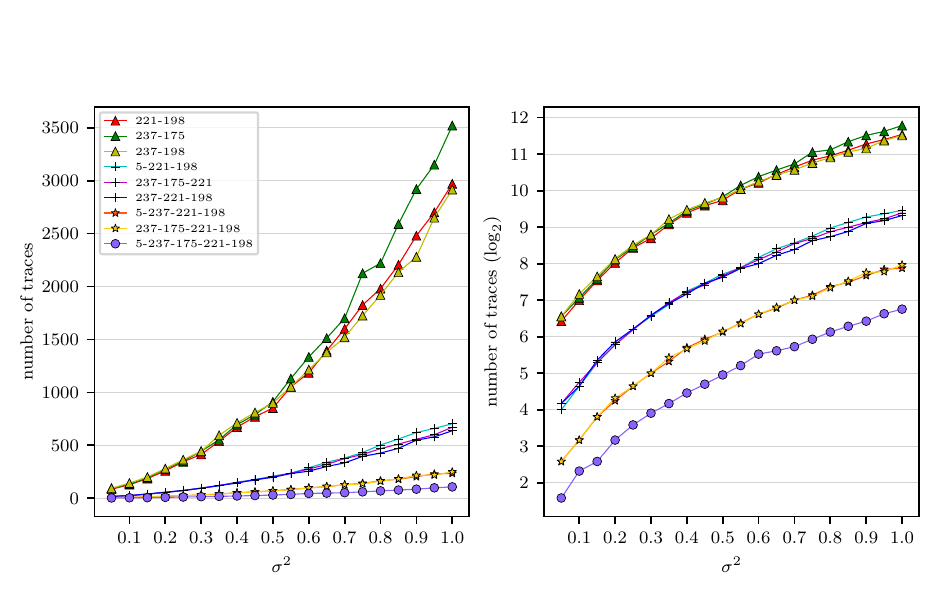
Figure 6: Attack on redundant masking scheme with 0 . 05 ≤ σ 2 ≤ 1 . 0 and 2 ≤ n ≤